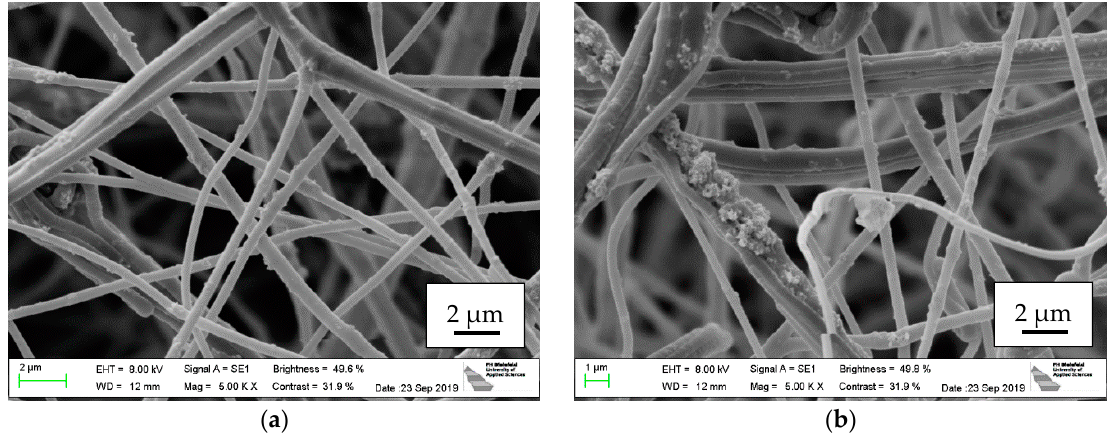
Figure 1. Scanning electron microscopy SEM images of an electrospun polyacrylonitrile (PAN)/ZnO nanofiber mat, taken at different sample positions.